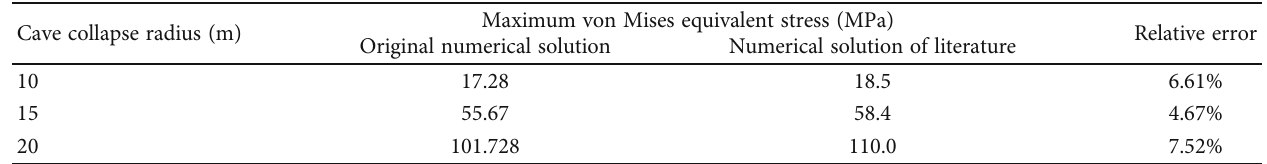
Figure 3: Model diagram. Table 4: Relative error of maximum von Mises equivalent